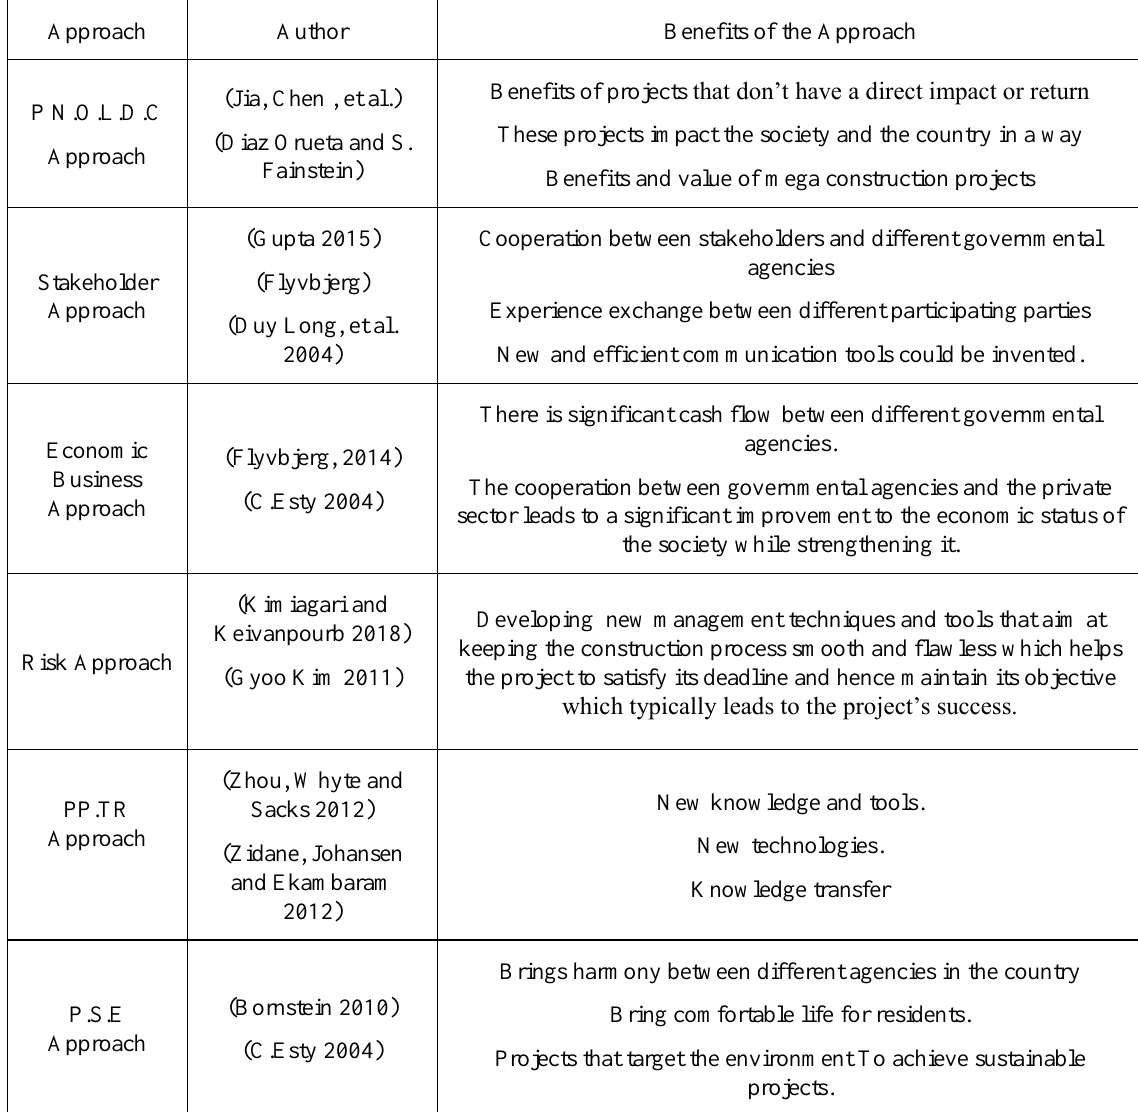
Table 4. Benefits of Mega Construction Projects with respect to different approaches “Source: Authors based on literature sources”